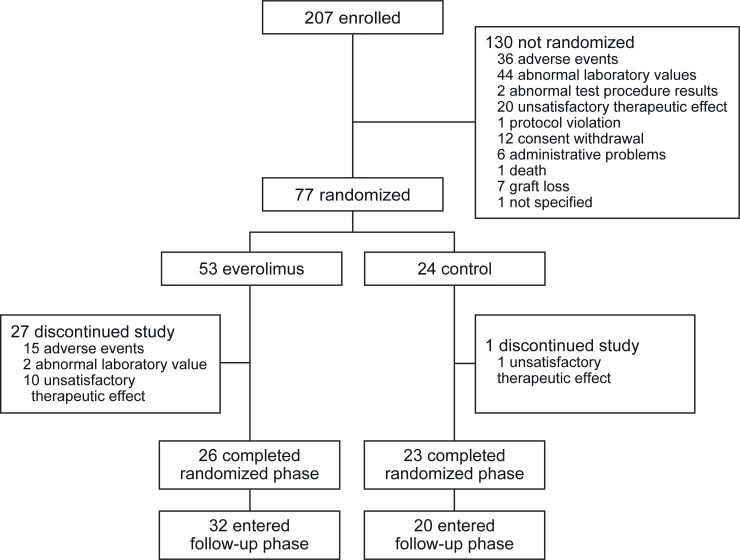
Patient disposition.